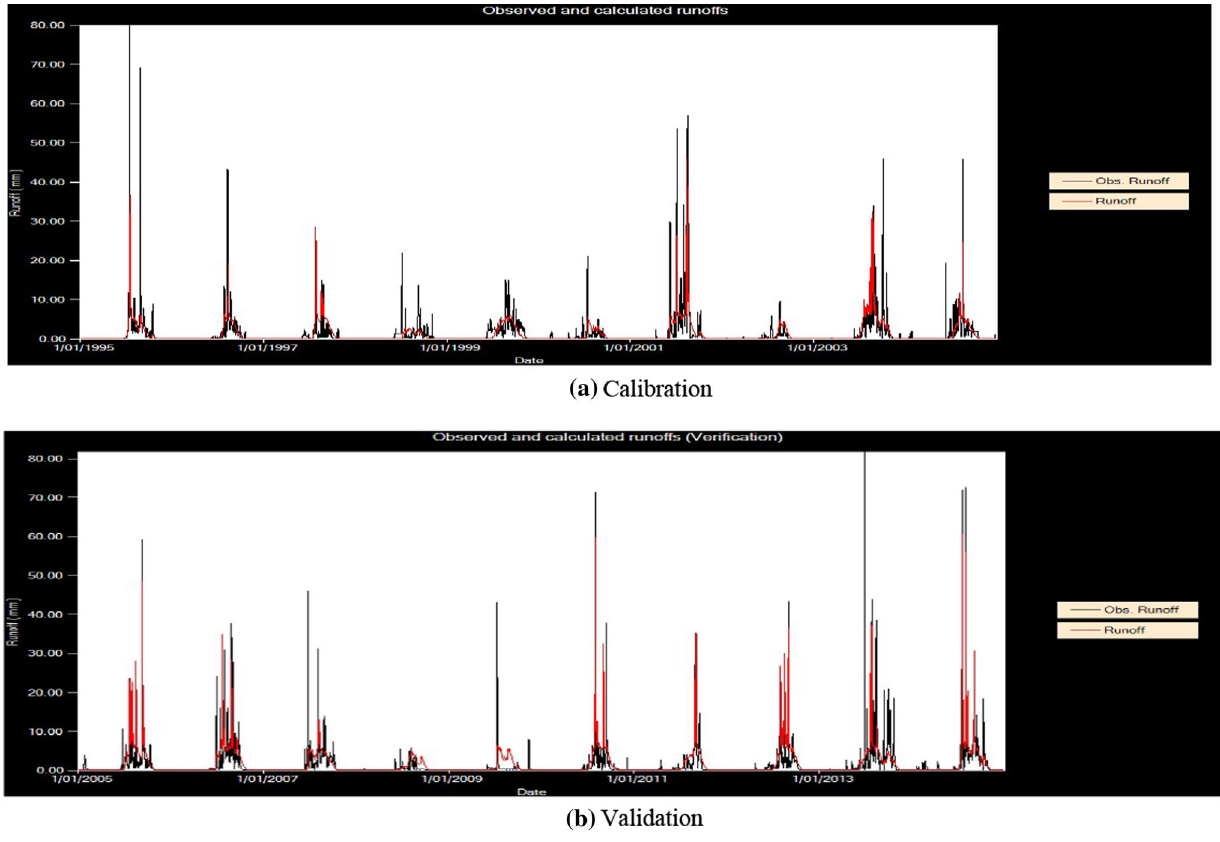
Fig. 4 Observed and simulated runoff from TANK model Table 5 Calibrated value and range of parameters of